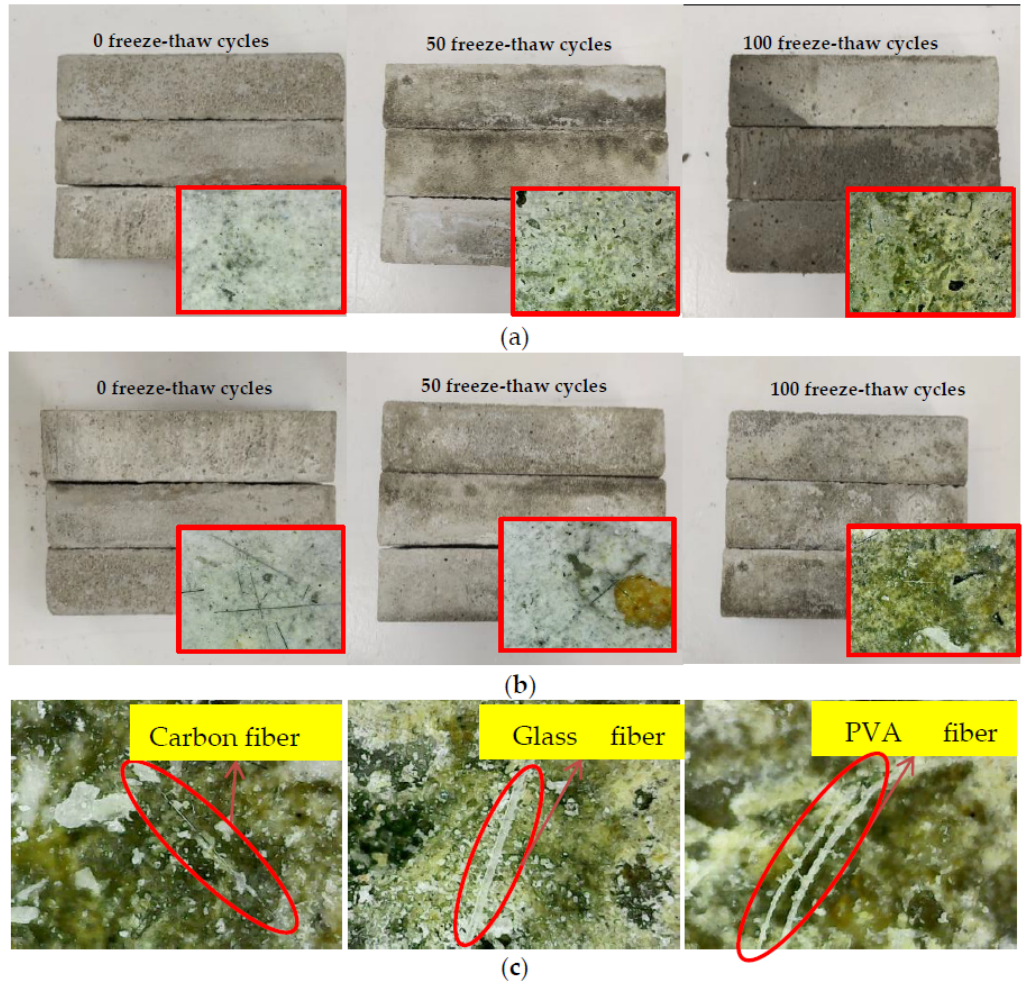
Figure 5. Surface condition of freeze-thaw specimen: ( a ) Without fiber; ( b ) With fiber; ( c ) Microscopic observation of different fibers.